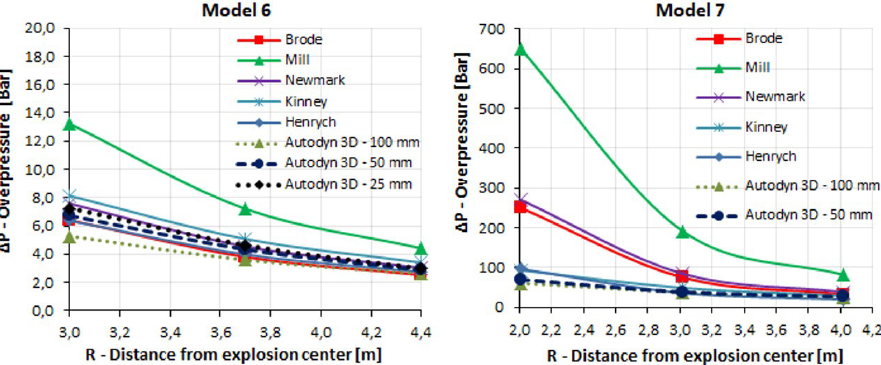
Figure 12. Overpressure peaks in gauges 1, 2, and 3 for models 6 and